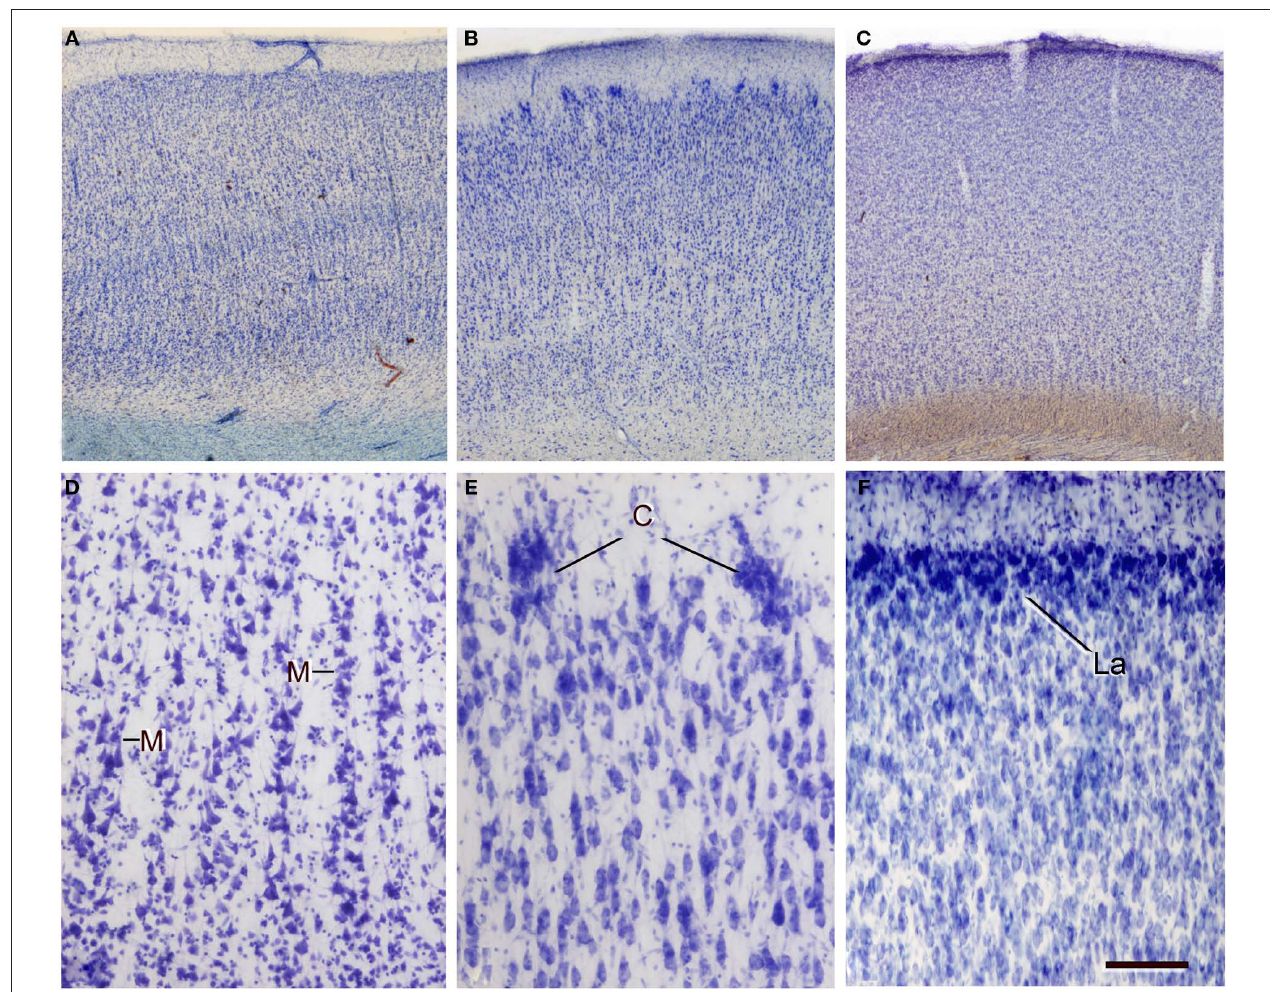
some clear cytoarchitectonic differences between the three species: (D) presence of vertical aggregates of neurons or minicolumns (M) in layers II–III of the human area 39; (e) clusters of neurons (C) in layer II of the giraffe; (F) highly cellular dense layer II (La) in the platypus. Note the obvious differences in the density of cells between the three species. Scale bar in (F) : 710 μm in (A–C) ; 100 μm in (D–F)